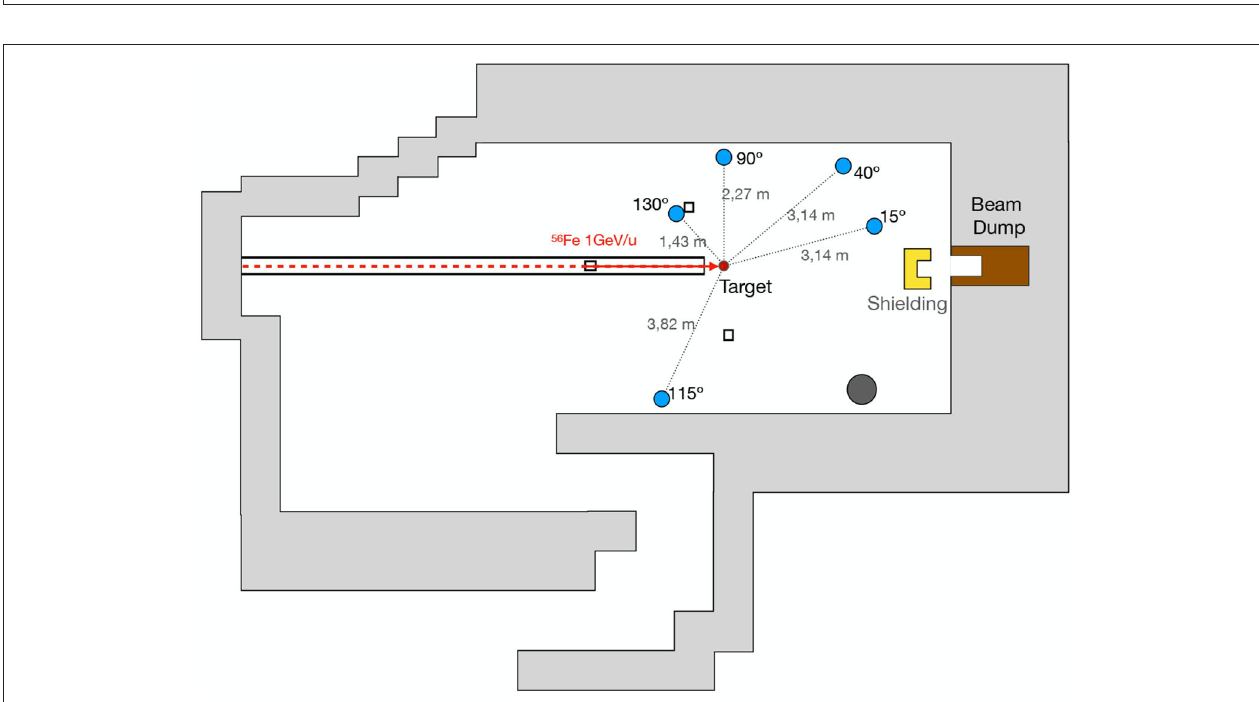
FIGURE 3 | Schematic representation of the experimental cave with its concrete walls and experimental setup and horizontal